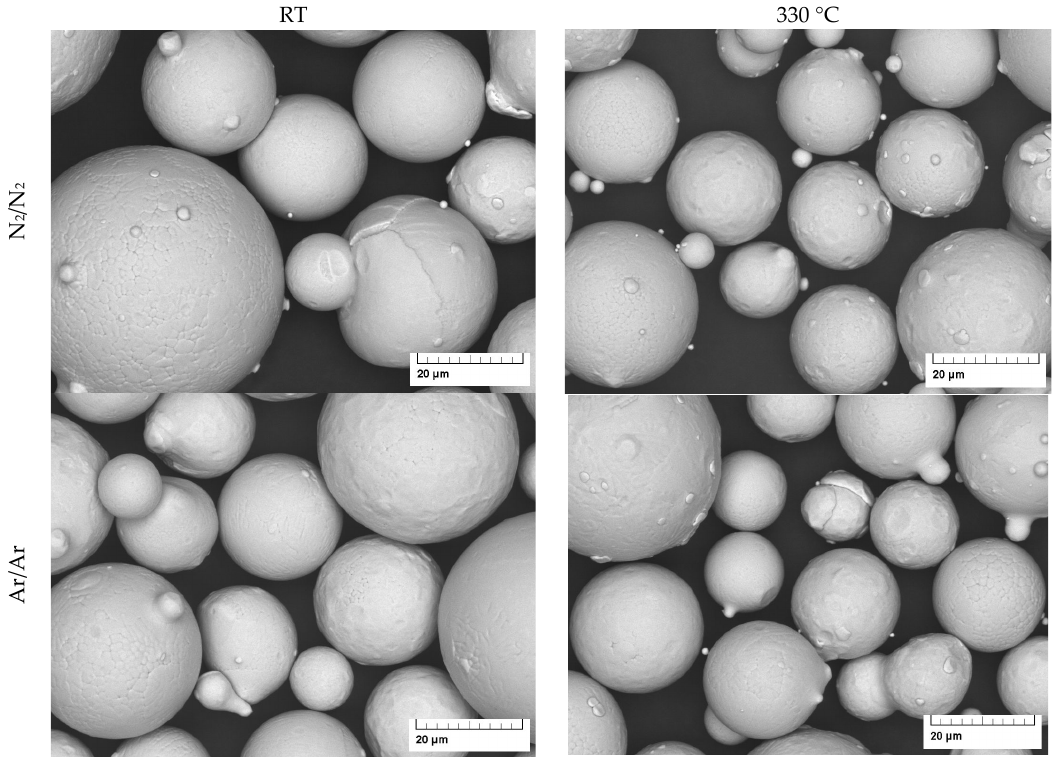
Figure 5. SEM images of gas atomized X2CrNiMoCuWN25-7-4 powders (particle size 20–63 µm, at high magnification).